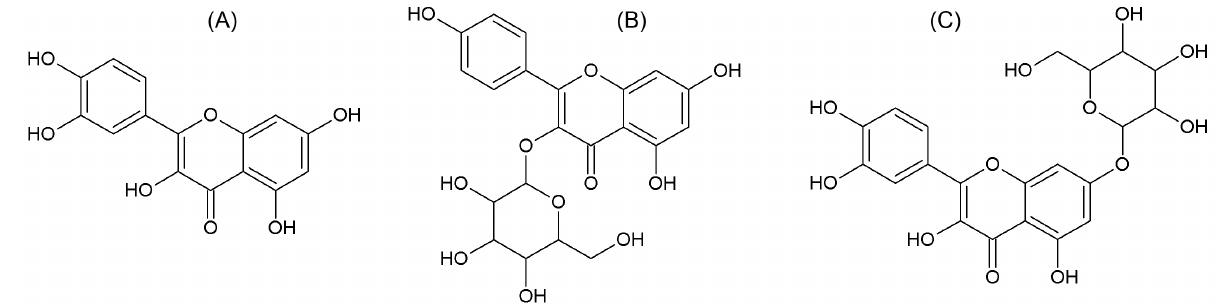
FIGURE 1 - Chemical structures of (1A) quercetin, (1B) astragalin and (1C) quercetin